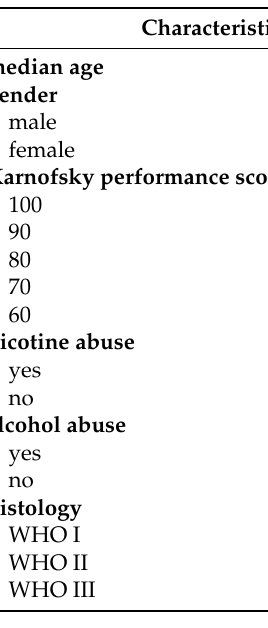
Table 1. Patient, disease, and treatment characteristics, n =